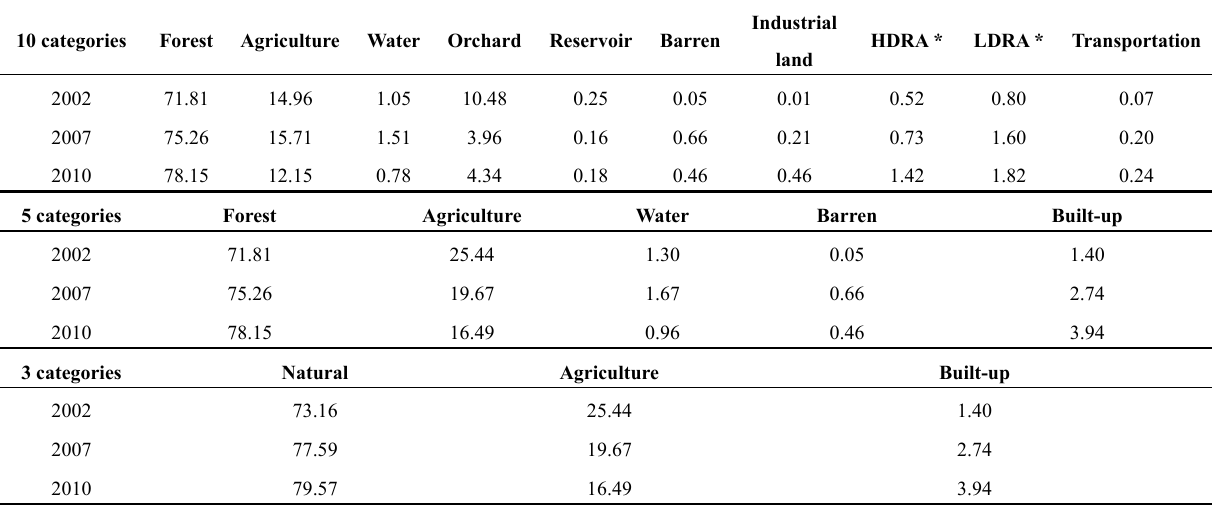
Table 2. Land use structure for three points in time and three levels of detail in the North River Watershed as a percentage of the total watershed